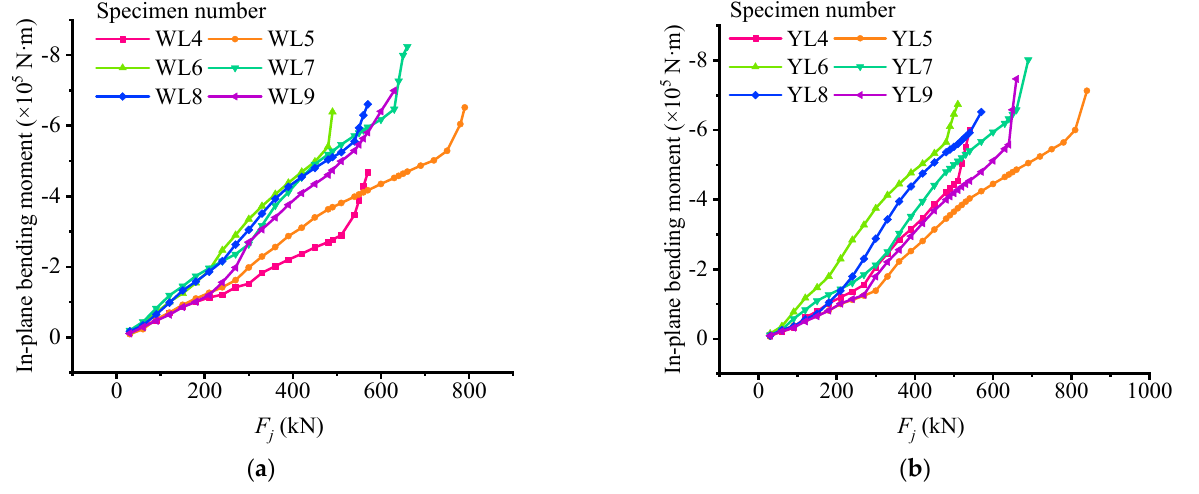
Figure 13. In ‐ plane bending moment diagram: ( a ) in ‐ plane bending moment of unbonded partially Figure 13. In-plane bending moment diagram: ( a ) in-plane bending moment of unbonded partially prestress beam; ( b ) in ‐ plane bending moment of bonded partially prestress beam. prestress beam; ( b ) in-plane bending moment of bonded partially prestress